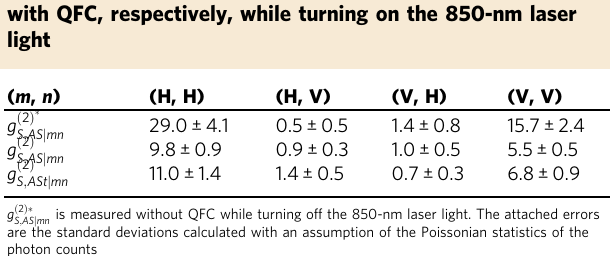
and g ð 2 Þ S ; AS j mn S ; ASt j mn